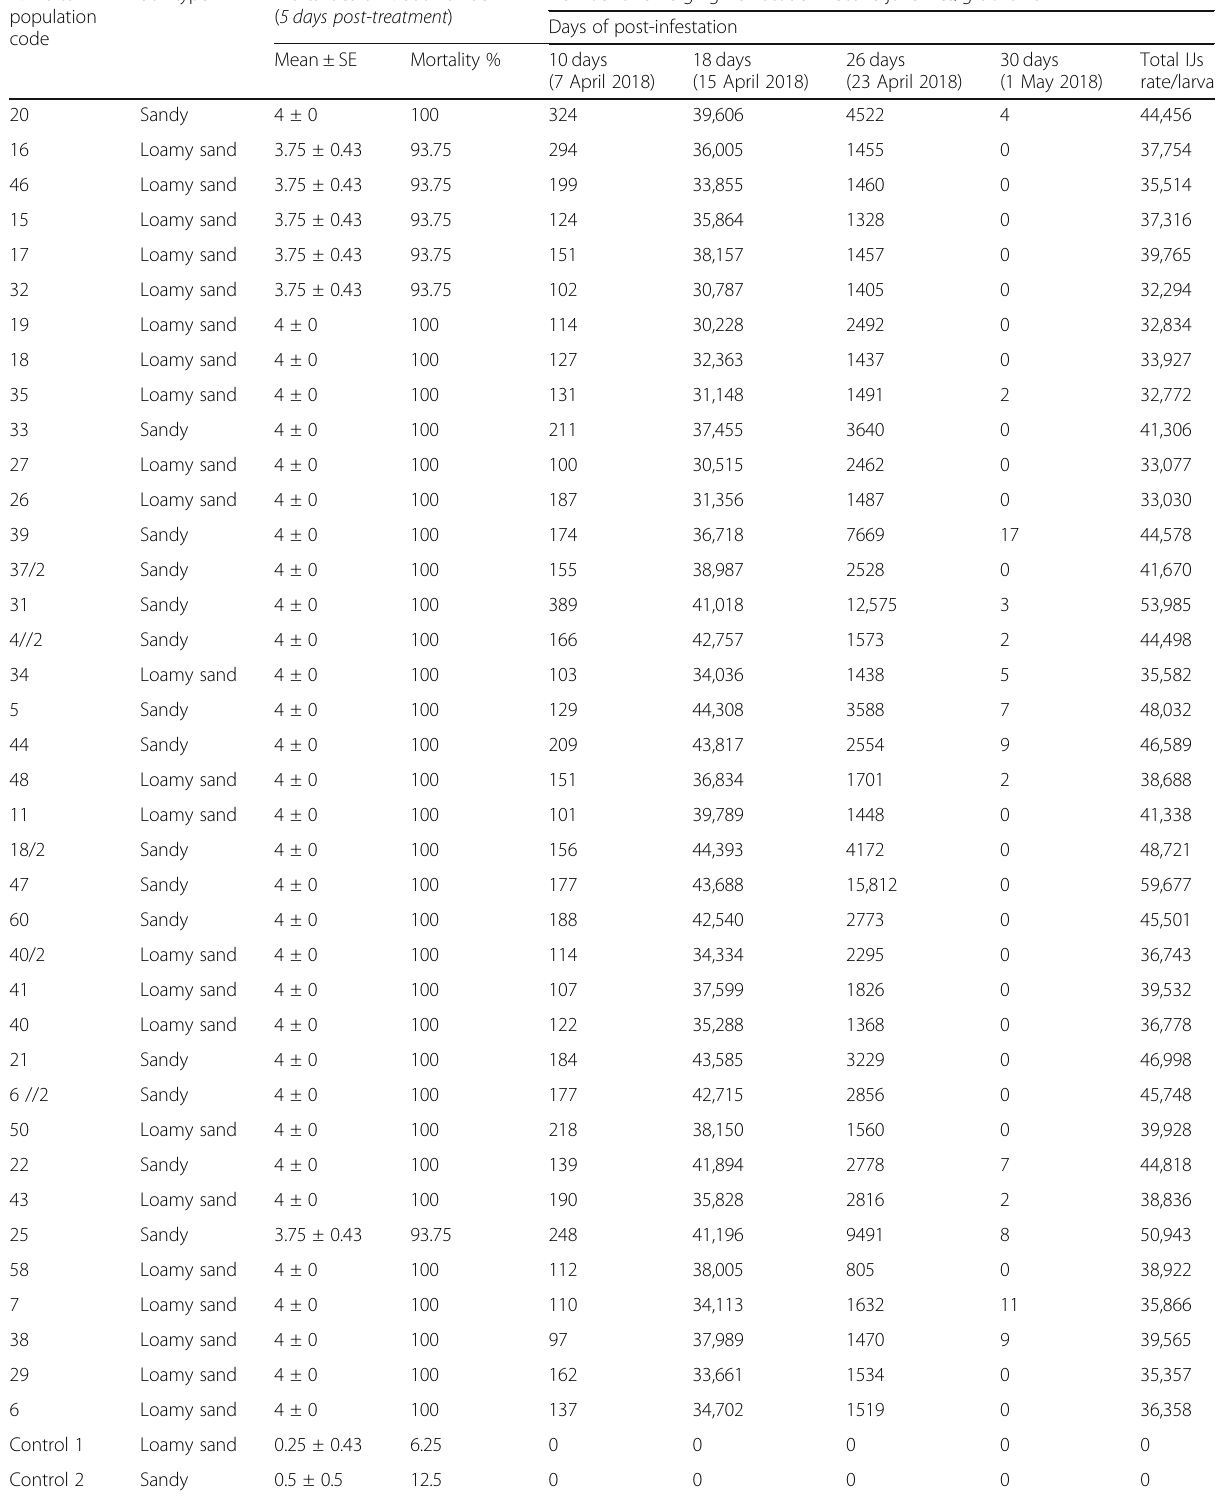
Table 1 Mortality of Temnorhynchus baal larvae after exposure to different populations of Heterorhabditis indica and numbers of emerging nematode-infective juveniles using 2 different types of soil as substrates (mean of four replicates (cups) each has four insects. The control has the grubs without